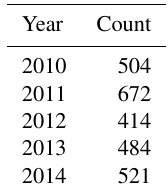
Figure 19. As for Fig. 10 but for 1904–1919. Table 6. Number of earthquakes added between 2010 and